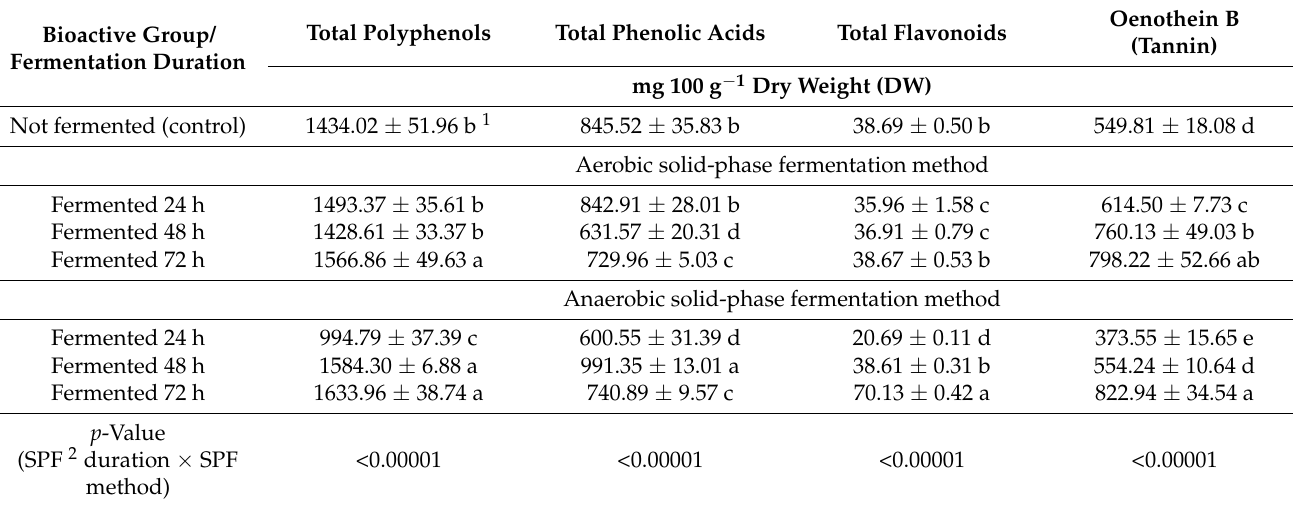
Table 1. The influence of solid-phase fermentation on the contents of total polyphenols, total phenolic acids, total flavonoids and Oenothein B (tannin) in fireweed leaves.